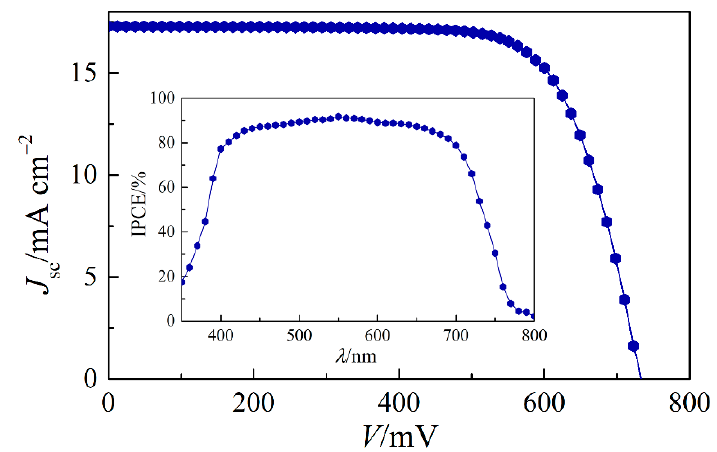
Figure 8. J – V characteristics of the cells based the DSSC based on the Sn-doped TiO 2 NWAs (TS2) with a light scattering layer under an irradiance of 100 mW cm − 2 simulated AM1.5G sunlight. The inset is its IPCE spectrum. Table 2. Detailed photovoltaic parameters of the DSSC based on the Sn-doped TiO 2 NWAs (TS2) with a light scattering layer under different incident light intensities.